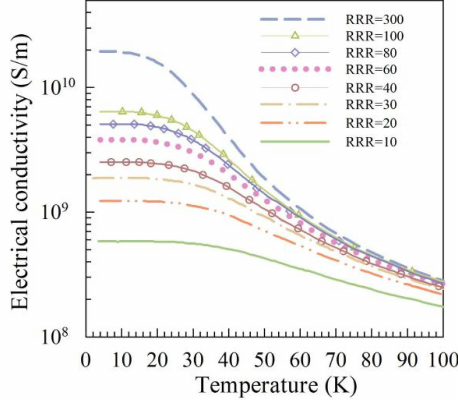
Figure 7. Temperature-dependent electrical conductivity of copper with different RRRs.